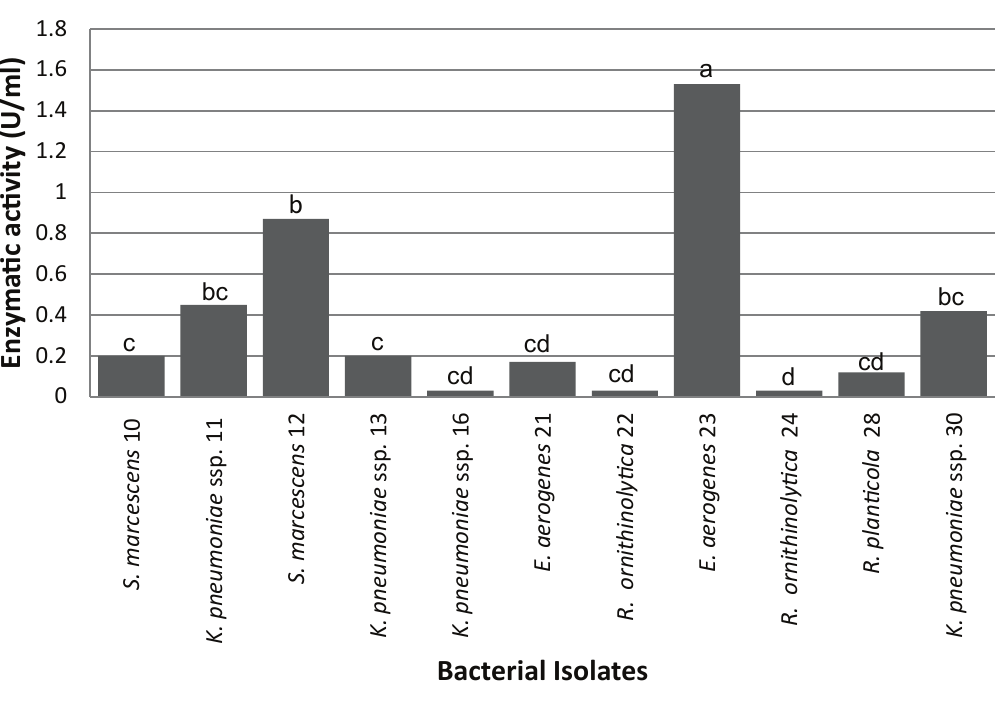
Figure 1 - Extracellular lipase enzymatic activity of bacteria obtained from effluents of dairy products and slaughterhouses industries located in Pelotas/RS, Brazil. * a,b,c,d Different letters indicate statistically significant difference according to the Duncan test